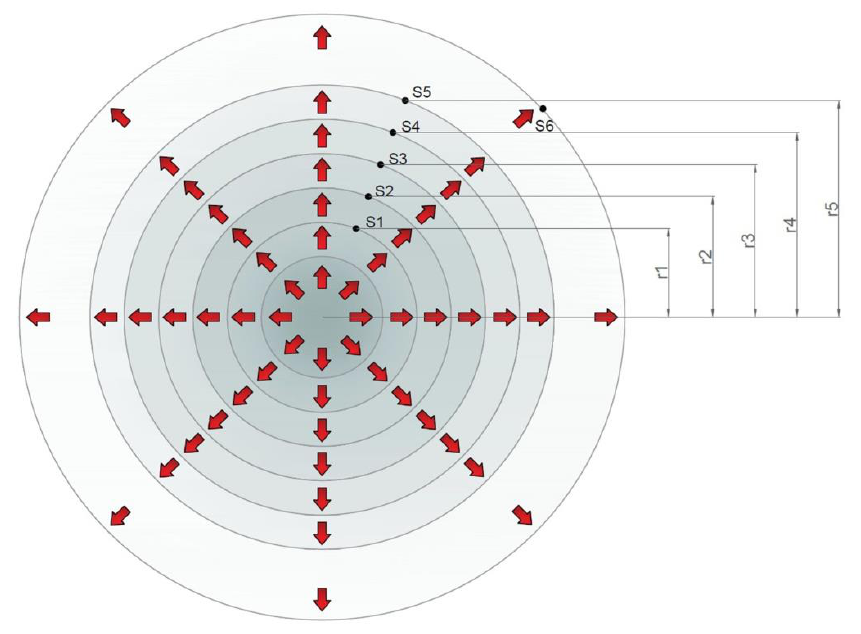
Figure 4. Heat transmission through the ground system and temperature sensors location.